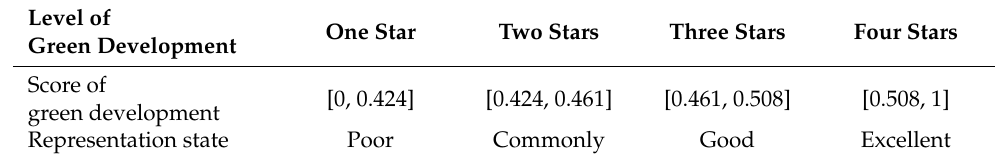
Table 12. Division of green development level of coal-resource-exhausted cities. Level of One Star Two Stars Three Stars Four Stars Green Development Score of [0, 0.424] [0.424, 0.461] [0.461, 0.508] [0.508, 1] green development Representation state Poor Commonly Good Excellent